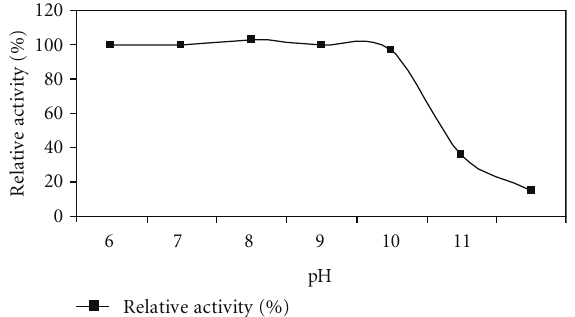
Figure 9: E ff ect of pH on activity of xylanase from Bacillus arseni- ciselenatis DSM 15340.